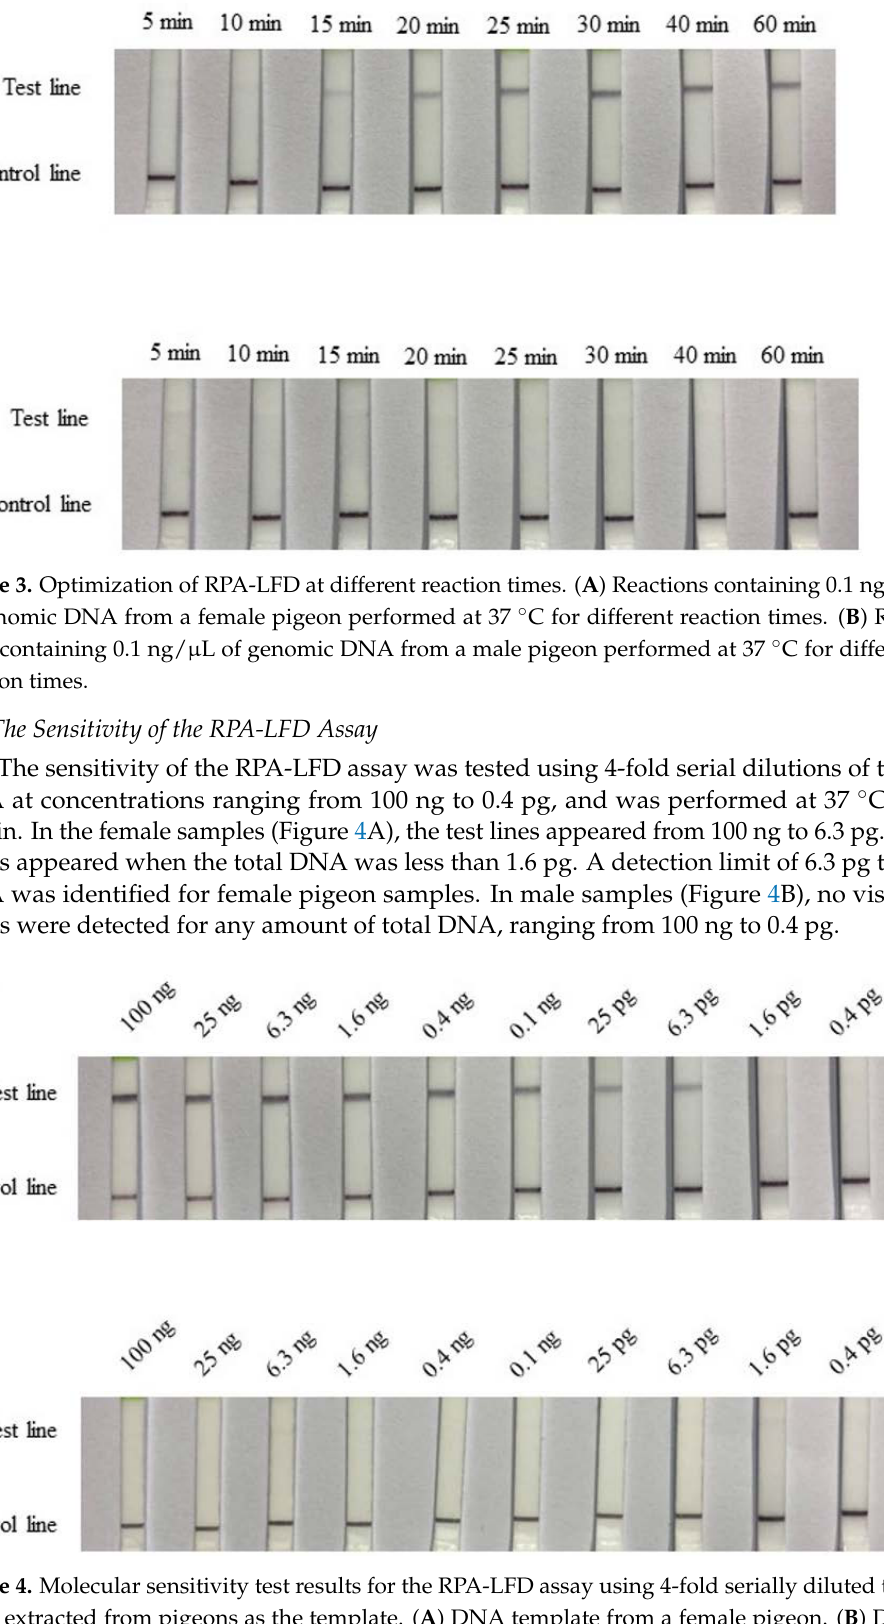
Figure 4. Molecular sensitivity test results for the RPA-LFD assay using 4-fold serially diluted total DNA extracted from pigeons as the template. ( A ) DNA template from a female pigeon. ( B ) DNA template from a male pigeon. In addition, a 100 ng, 25 ng, 6.3 ng, 1.6 ng, 0.4 ng, 0.1 ng, 25 pg, 6.3 pg, 1.6 pg, and 0.4 pg dilution series of total DNA was prepared from female and male pigeons.